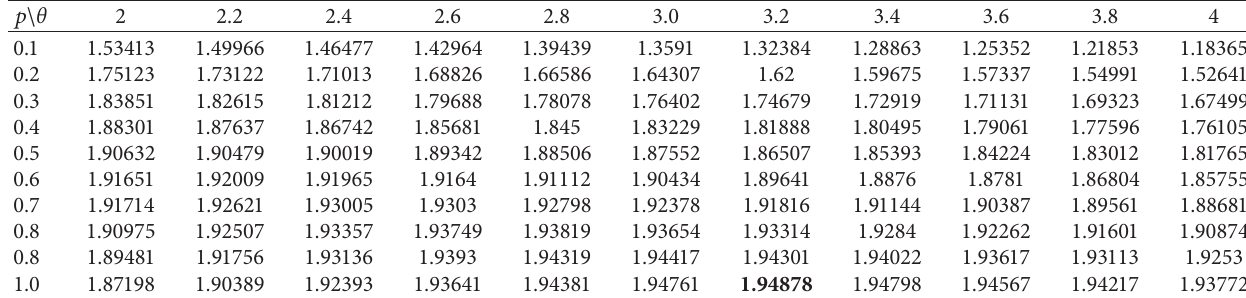
� 0 . 2 ,C � 0 . 3 , C � 0 . 1 ,C � 0 . 1 ,C � 0 . 2 , C � 0 1 2 3 4 5